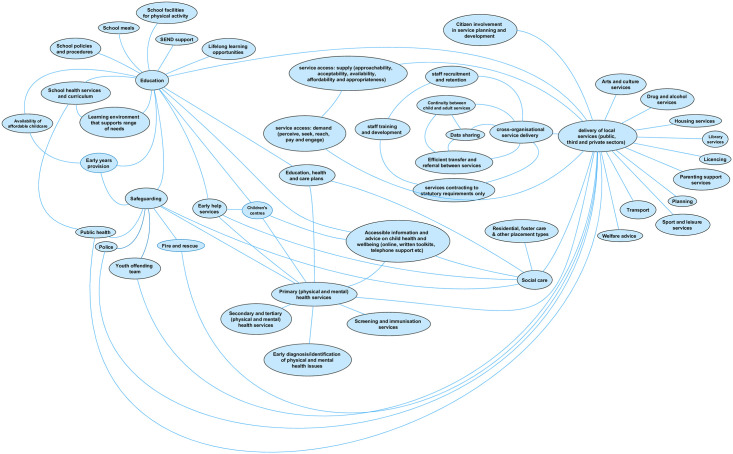
The service domain.